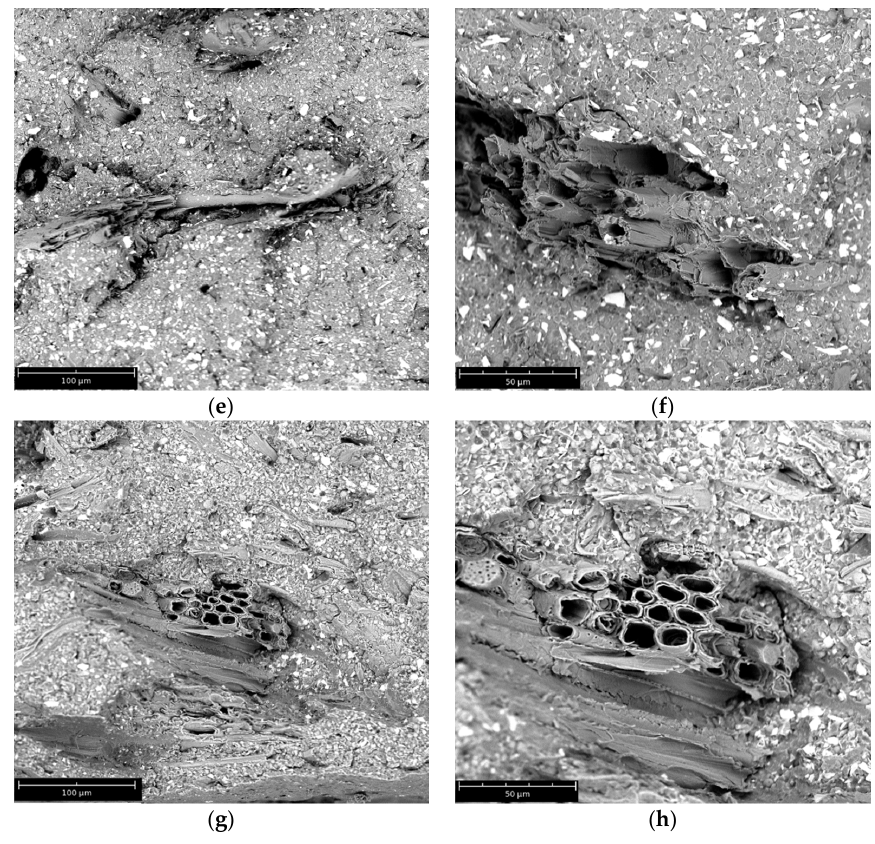
Figure 5. Morphology of fractured surfaces of samples ( a , b ) V ‐ 15; ( c , d ) V ‐ 30; ( e , f ) R4 ‐ 15; ( g , h ) R4 ‐ 30 at different magnifications.